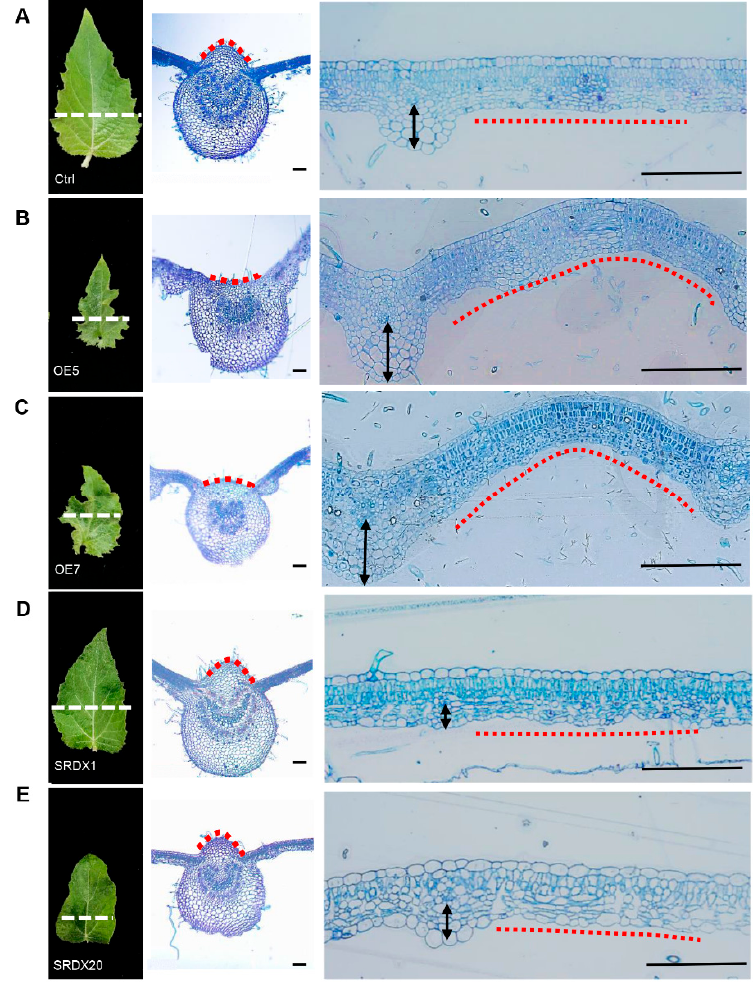
Figure 3. Abnormal expression of PagKNAT2/6b affects leaf adaxial-abaxial development. The left panel of ( A – E ) are morphologic overviews of LPI3. The white dotted line shows the positions for microsection preparation in the middle and right panels. The middle panel shows views of the main leaf midrib, and the red dotted lines point to the differences on the adaxial side of the main leaf midrib in different genotypes ( A – E ). The right panel shows views of the lateral leaf midrib, and the black arrows and red dotted lines show the difference on the abaxial side of the lateral leaf midrib of different genotypes ( A – E ). ( A – E ), Ctrl, OE5, OE7, SRDX1, and SRDX20, respectively. Bars = 100 µ